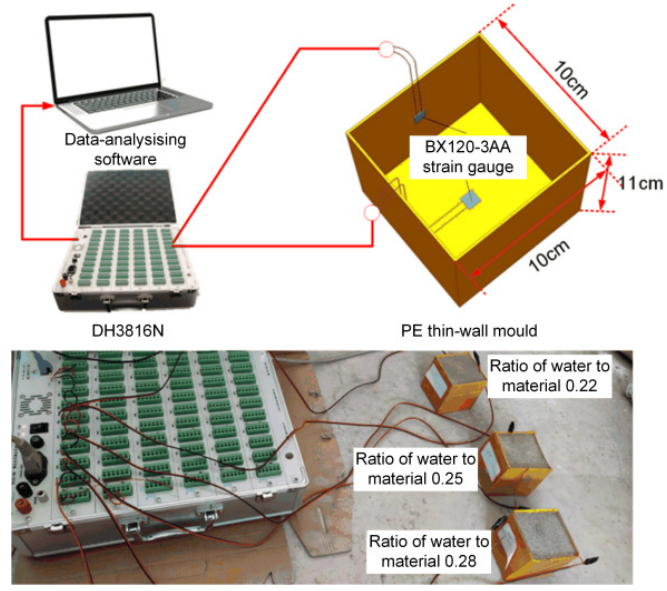
Figure 3. Free solidification strain test scheme.